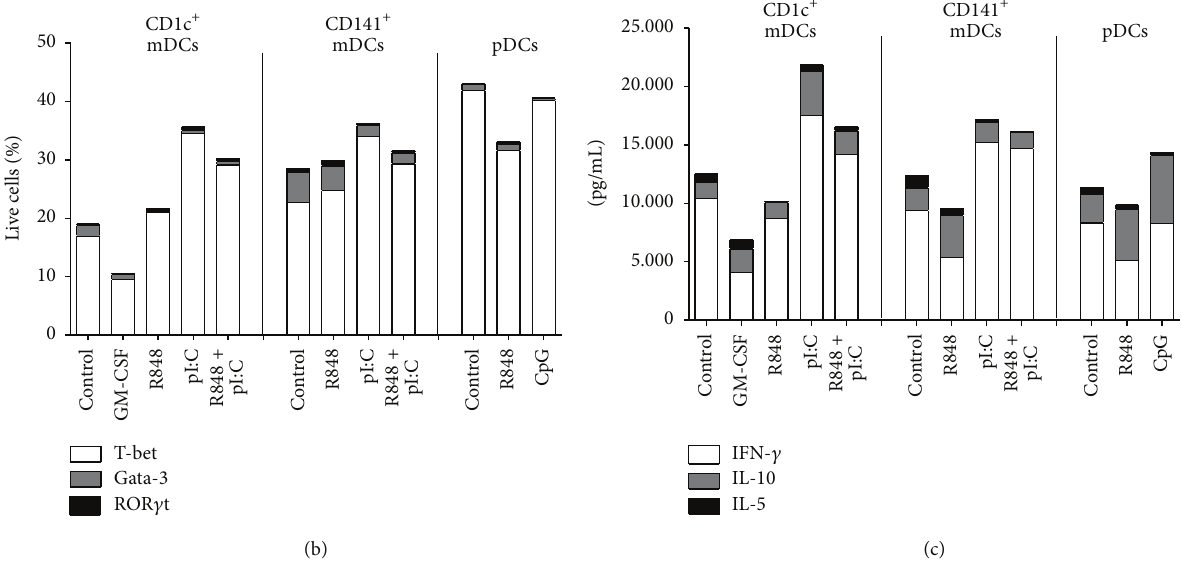
Figure 4: Mature human DC subsets can skew naive CD4 + T cells towards Th1 phenotype and do not induce a big population of Tregs. Human blood DCs were incubated with the indicated stimuli. The next day, allogeneic naive CD4 + T cells were added to the DCs together with a low concentration of the superantigen SEB (10pg/mL) and cultured until resting (11–13 days). (a) These CD4 + T cells were analyzed by flow cytometry for presence of a Treg population (CD25 + CD127 − FoxP3 + CD4 + T cells) ( 𝑛 ≥ 5 ). (b) The cells were also stained for the expression of transcription factors T-bet, Gata-3, and ROR 𝛾 t. In the lower panel, all three transcription factors are depicted in a single bar graph (mean value for each). (c) Furthermore, 5 × 10 4 of these CD4 + T cells were restimulated for 24 hrs with anti-CD3/anti-CD28 beads. Supernatants were analyzed for IL-5, IL-10, and IFN- 𝛾 by sandwich ELISA ( 𝑛 ≥ 4 ). The bar graphs show mean cytokine production ± SEM. In the lower panel, all three cytokines are depicted in a single bar graph (mean value for each cytokine). Significance comparing different conditions of the same subset was determined by Kruskal-Wallis test followed by Dunn’s testing (a and c), by a 1-way ANOVA followed by Tukey testing or a paired 𝑡 -test (b) ( ∗ 𝑃 < .05 ; ∗∗ 𝑃 < .01